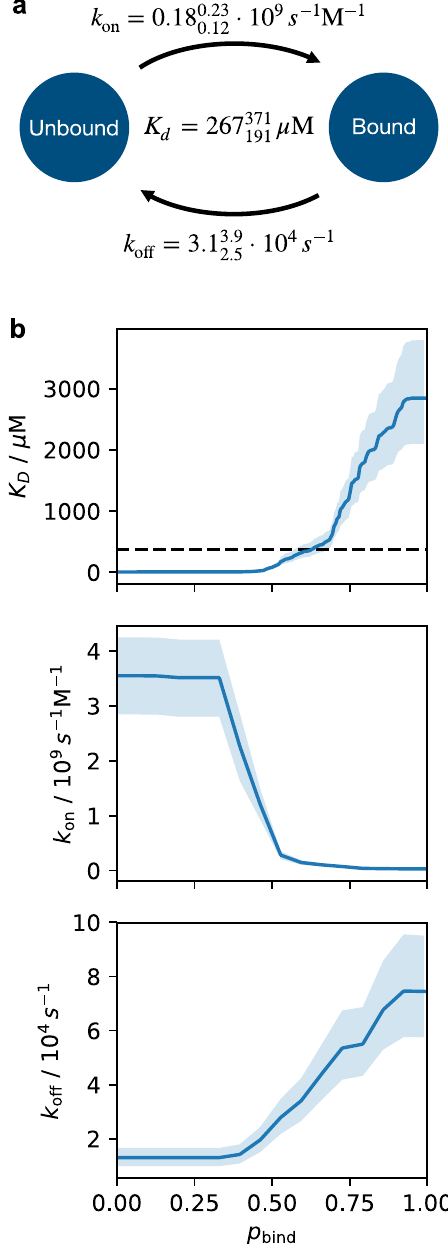
Fig. 6 Binding kinetics in the MSM. a On-rate k on , off-rate k off , and dissociation constant K d of ubiquitin and SH3c calculated from the MSM ¼ 0 : 57 at which the experimental for the state threshold value p (cid:4) bind value for K d is obtained. Unbound/bound states of the MSM are de fi ned as states with p (cid:4) values smaller/larger than the state threshold value. bind Super and sub-scripts indicate a 95% con fi dence interval of the posterior distribution of the MSM transition matrix. b K d , k on , and k off , as ¼ 0 : 57 a function of the state threshold value p (cid:4) . The threshold p (cid:4) bind bind in ( a ) is located within a plausible transition state region. However, the entire range of predicted K d values for different threshold choices is within the expected error of current state-of-the-art force fi eld. The rates in subscript and superscript in ( a ) and the error regions in ( b ) represent 95% con fi dence intervals of the posterior distribution of Markov